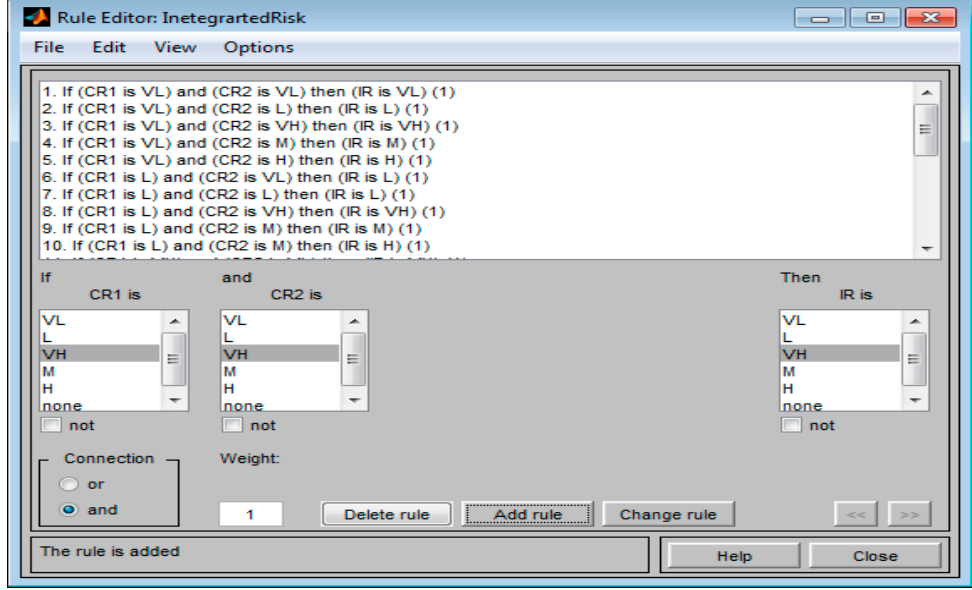
Figure 10. Rule editor for specifying maximum rule-based methods rules.